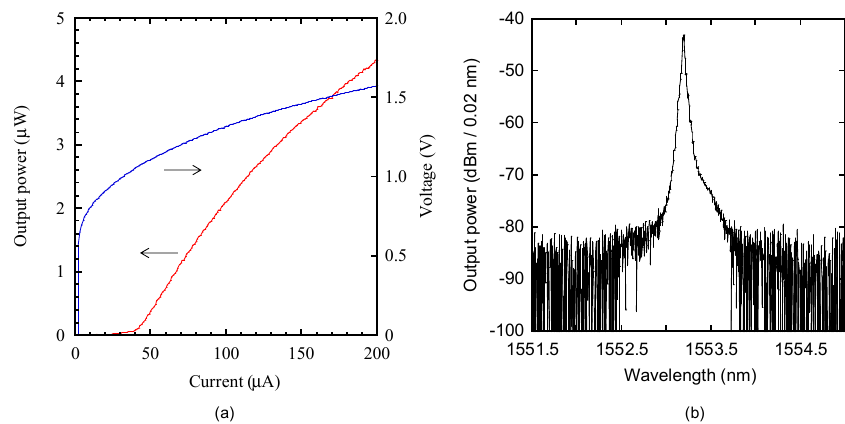
Figure 8. ( a ) I-L-V characteristics under RT-CW operation. ( b ) Lasing spectrum at bias current of 60 μ A.